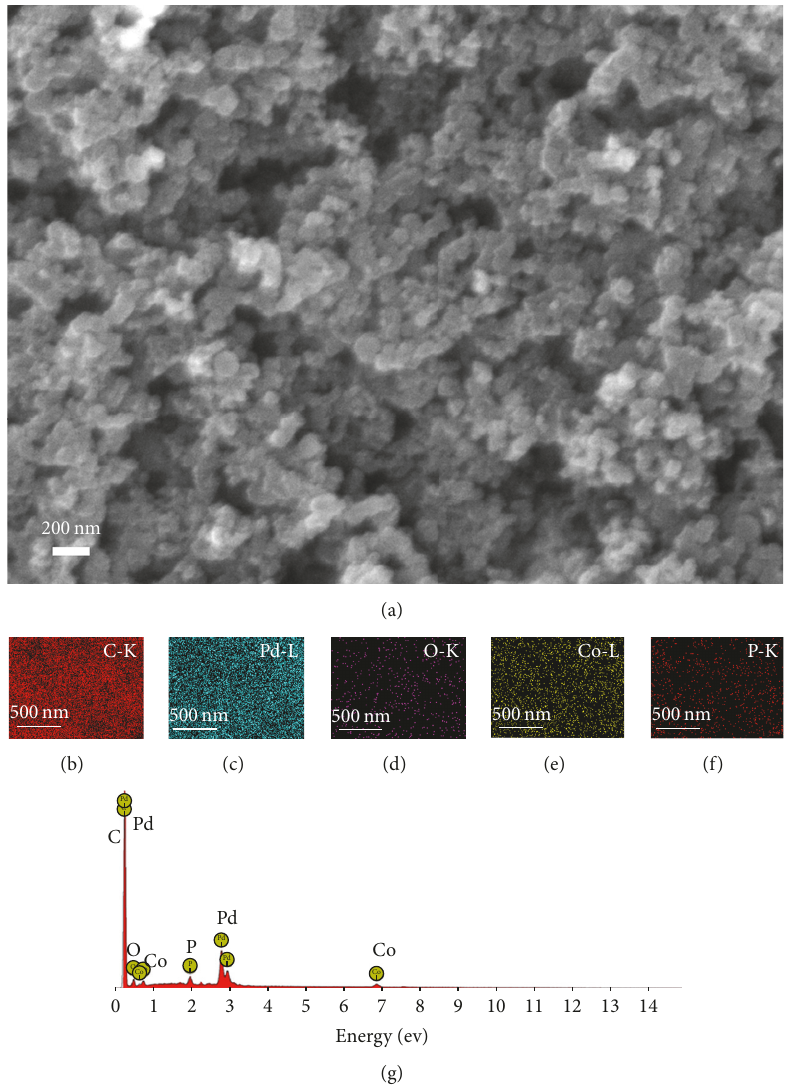
Figure 5: SEM image (a); element mapping images (b)–(f) for C, Pd, O, Co, and P in the C/Co 2 P/Pd composites and EDX spectrum of the C/Co 2 P/Pd